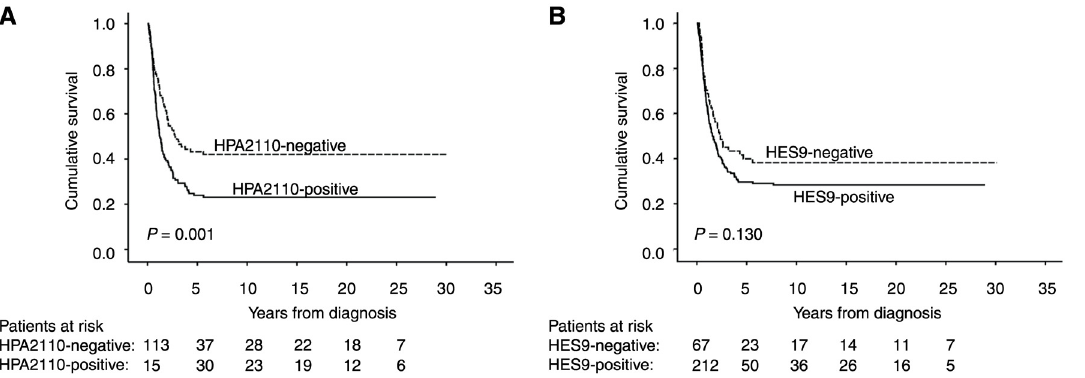
Fig 2. Gastric-cancer-specific survival according to the Kaplan – Meier method. (A) HPA2110 and (B) HES9 expression and survival in gastric cancer